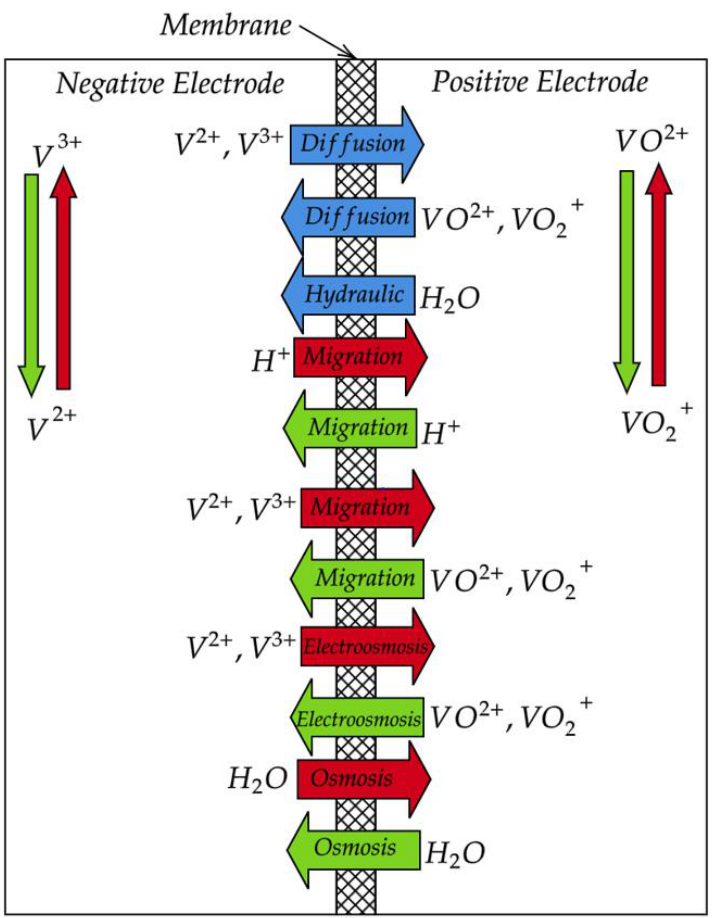
Figure 3. Crossover mechanisms in a vanadium redox flow battery during charge (green arrows) and discharge (red arrows).